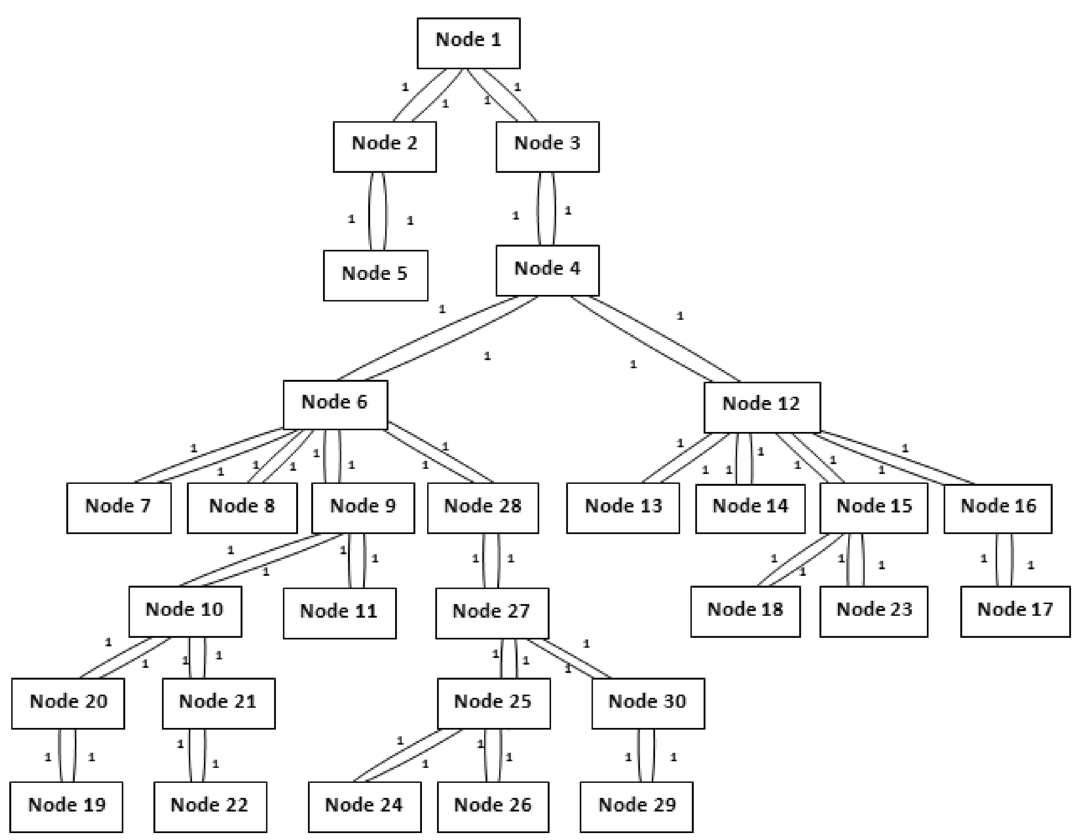
Fig. 7 Optimal radial network obtained by applying Kruskal’s algorithm for base loading condition and 90% base-load condition